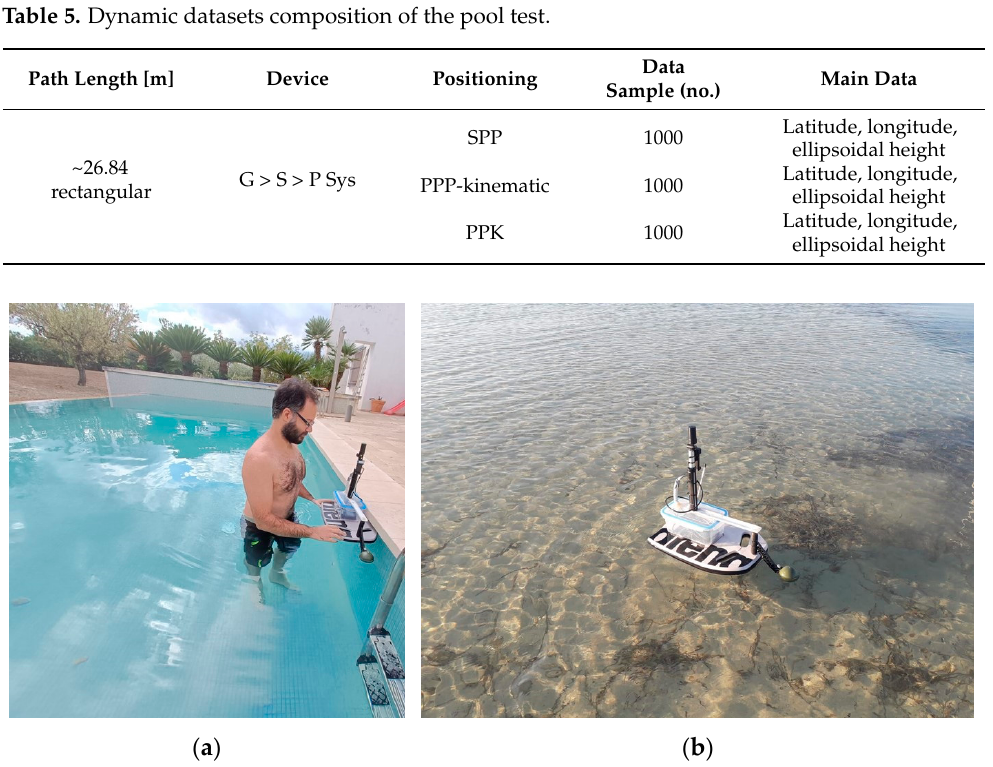
Table 5. Dynamic datasets composition of the pool test.